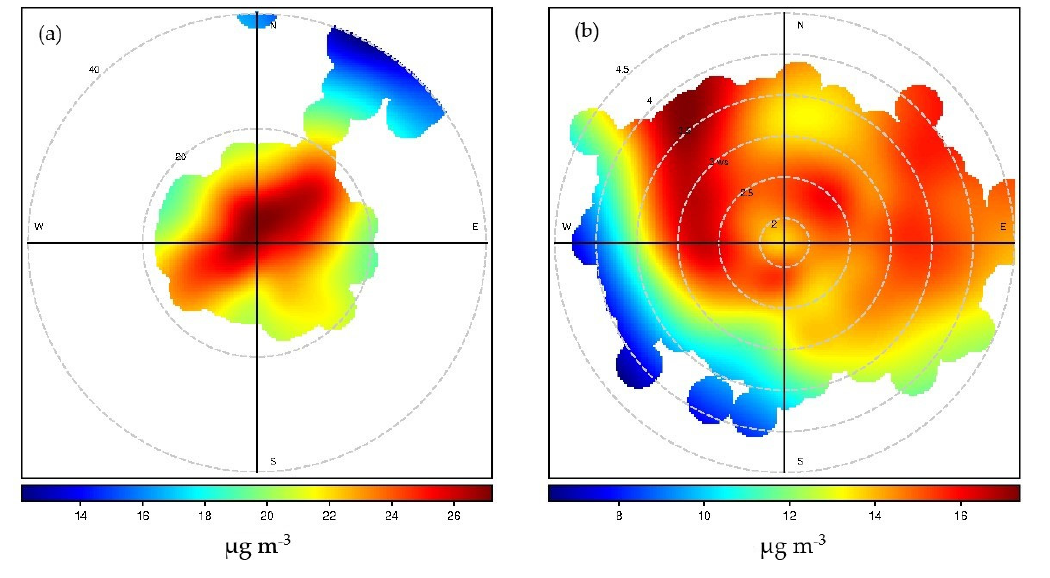
Figure 4. Pollution roses for ( a ) Obispado and ( b ) Pueblo Serena site.